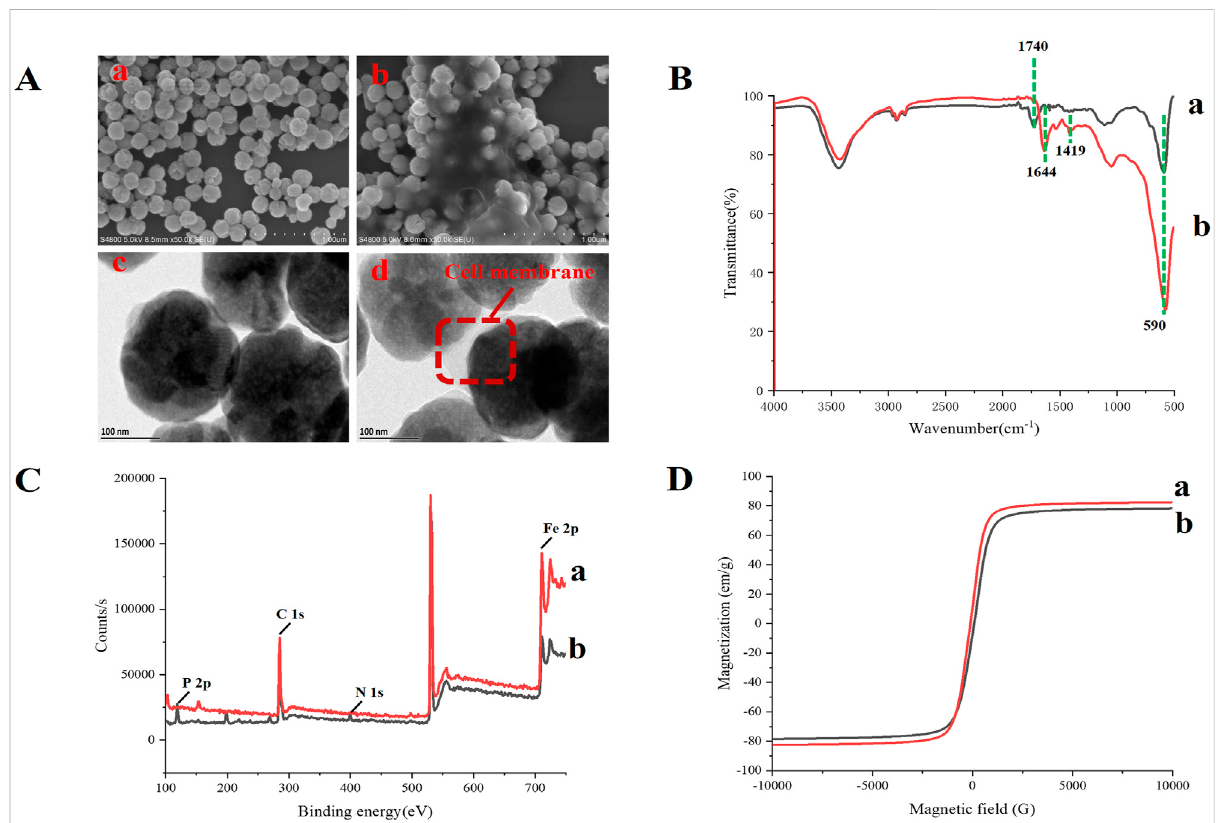
FIGURE 3 Characterization of CMs@HT22-MBs and MBs. The morphology of CMs@HT22-MBs and MBs was observed through transmission electron microscopy (TEM) and scanning electron microscopy (SEM). Fourier transform infrared spectroscopy (FTIR) spectra of the obtained materials were acquiredonaFTIRspectrometerfrom4,000to400 cm − 1 toobservethechangesintheirfunctionalgroups.X-rayphotoelectronspectroscopy(XPS) was used to analyze the surface elemental composition of the obtained materials. Magnetic measurements were performed using vibrating sample magnetometry (VSM). (A) SEM images of MB (a) and CMs@HT22-MBs (b) ; TEM images of MB (a) and CMs@HT22-MBs (b). (B) FTIR spectra of (a) MBs and (b) CMs@HT22-MBs. (C) XPS of (a) MBs and (B) CMs@HT22-MBs. (D) Magnetic hysteresis loops of (a) MBs and (b)